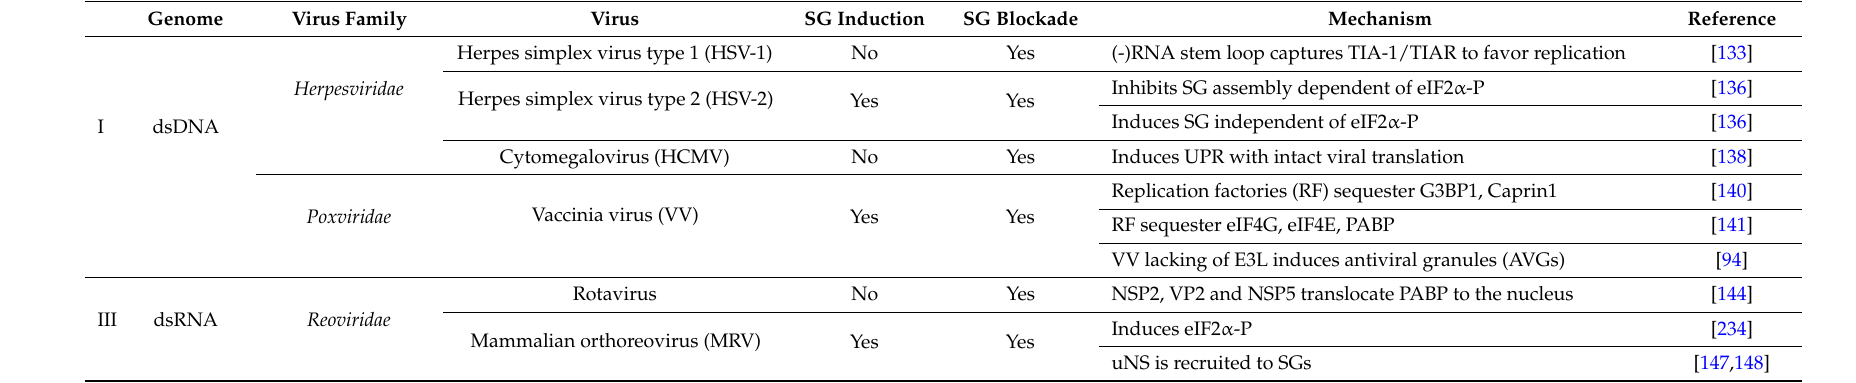
Table 2. Virus families that modulate